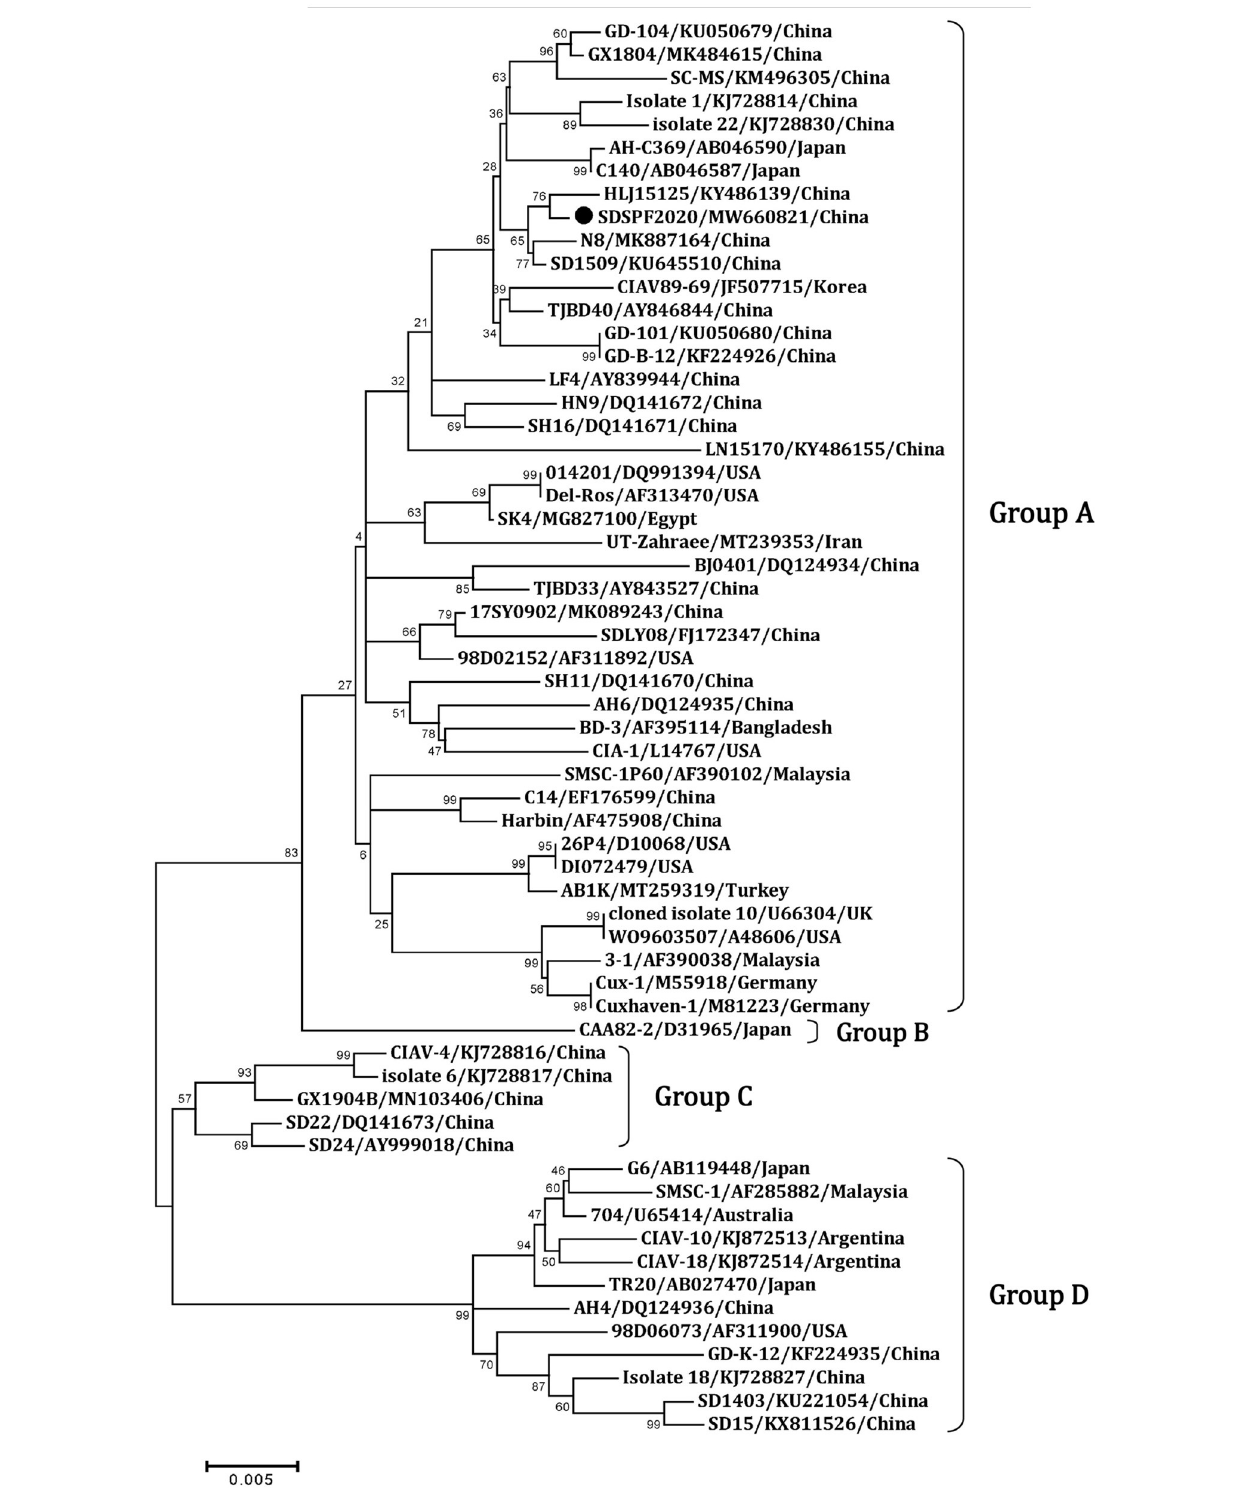
FIGURE 2 | Phylogenetic diagram of viral protein 1 genes among CIAV strains. The CIAV strain determined in this work is highlighted in a black dot, and reference sequences from GenBank were given the name followed by accession number and country. The numbers near the branches indicate bootstrap values. The four major groups were identified as A, B, C and